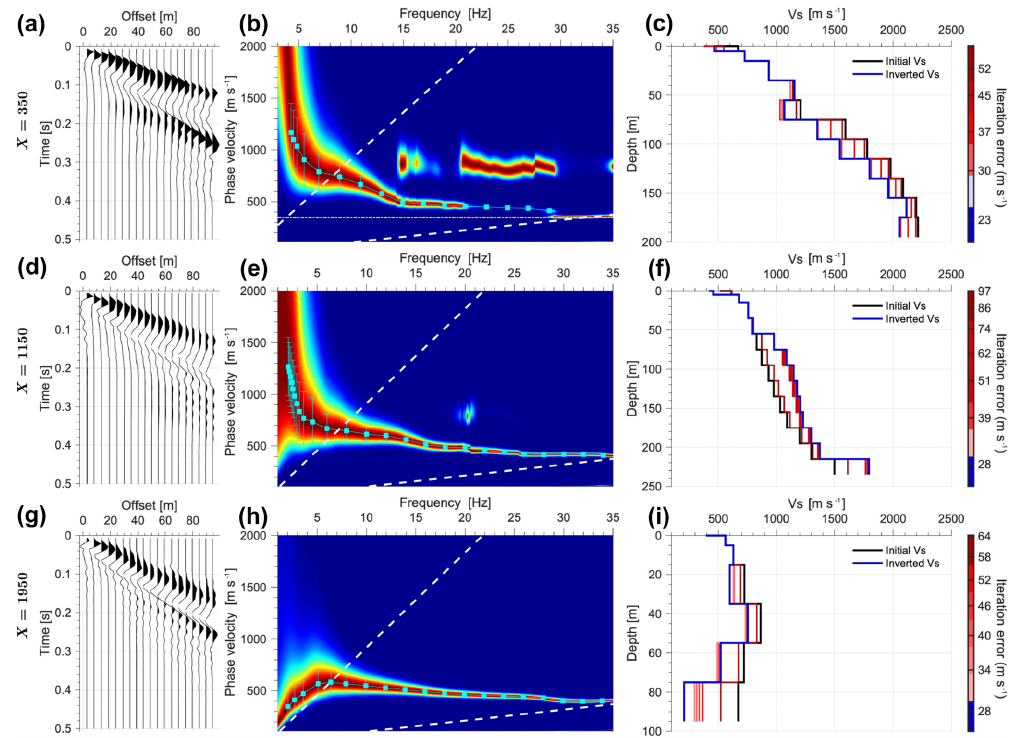
Figure 7. Three examples of dispersion curves obtained from source–receiver sorting and offset stacking. Each dispersion curve is represen- tative of a 100m long section along the profile (see Fig. 8 for location). (a, d, g) Stacked virtual source gather; (b, e, h) dispersion curves and picks. (c, f, i) Inverted V s (z) for all iteration steps. The blue curve (lowest data misfit) represents the accepted final model.